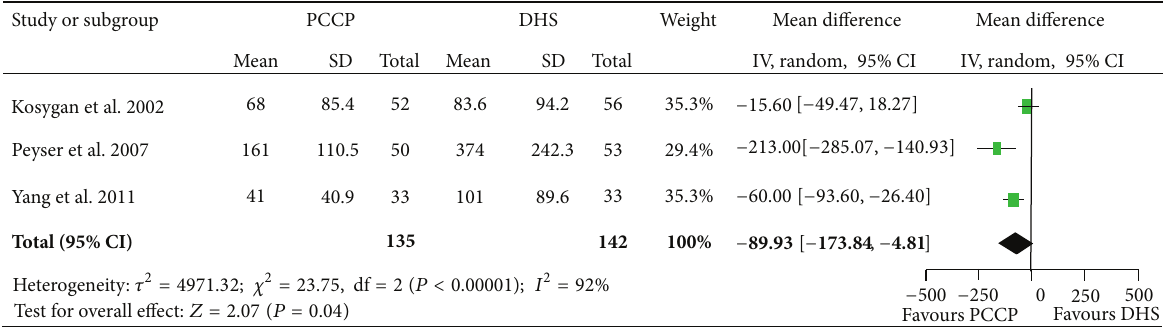
Figure 4: Comparison of blood loss between PCCP and DHS.